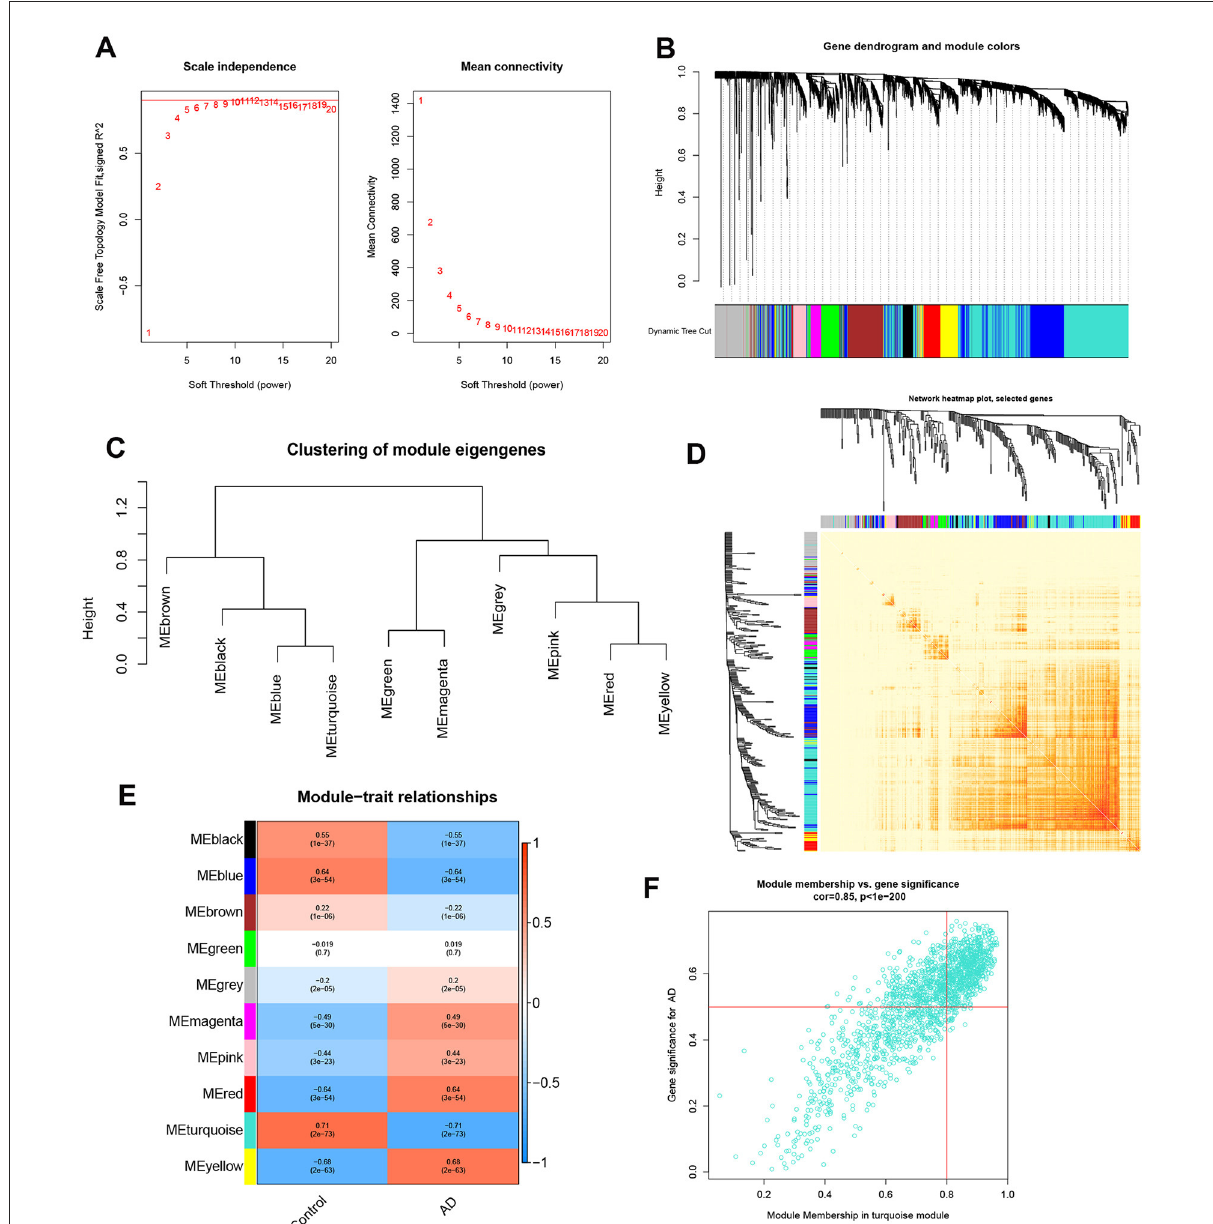
FIGURE5 Co-expression network of differentially expressed genes in AD. (A) The selection of soft threshold power. (B) Cluster tree dendrogram of co-expression modules. Different colors represent distinct co-expression modules. (C) Representative of clustering of module eigengenes. (D) Representative heatmap of the correlations among 10 modules. (E) Correlation analysis between module eigengenes and clinical status. Each row represents a module; each column represents a clinical status. (F) Scatter plot between module membership in turquoise module and the gene significance for